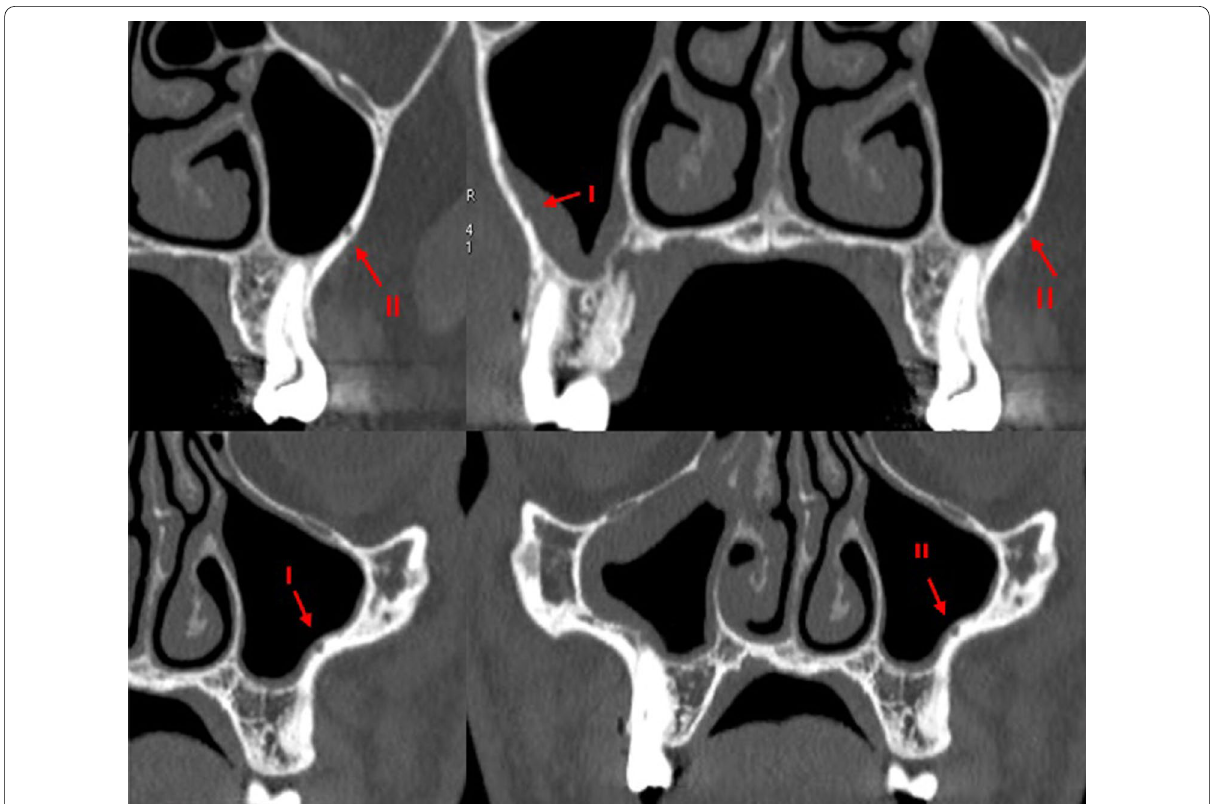
Fig. 2 Different variations of PSAA (I/Intrasinus; II/Intraosseous) seen in sagittal